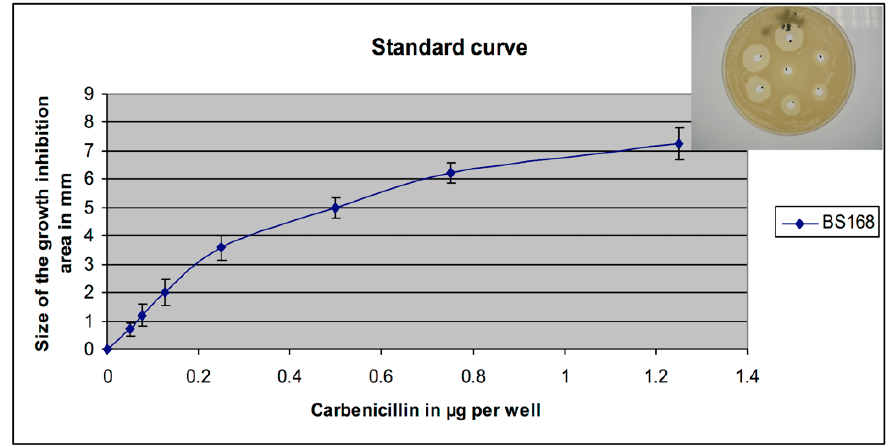
Figure 10. Range of sensitivity of Bacillus subtilis 168 to carbenicillin. About 1 × 10 6 bacteria were spread on the LB-agar plate. After 1 h of incubation at 37 °C, holes were drilled in the agar with a sterile Pasteur pipette and 50 µL of a solution containing increasing quantities of carbenicillin were added to each well. After 24 h of incubation at 37 °C, the size of each halo of growth inhibition was measured and plotted as a function of the quantity of carbenicillin in the wells. Such a standard range was performed for each carbenicillin input measurement experiment in PAO1 or its mutant